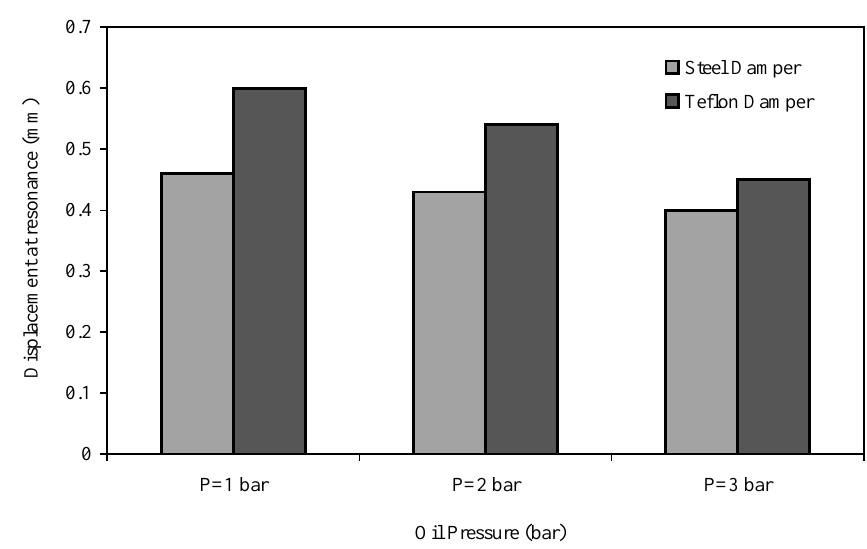
Fig. 10. Oil pressure effect on Displacement at